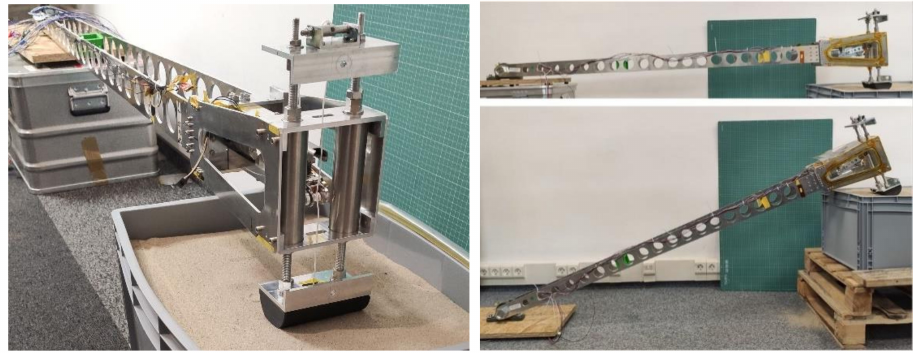
Figure 6. ( Left ) The actual implementation of the compression springs suspension in the BB-0B testbed. ( Right ) Horizontal (0 ◦ ) and inclined (20 ◦ ) configurations of the testbed.